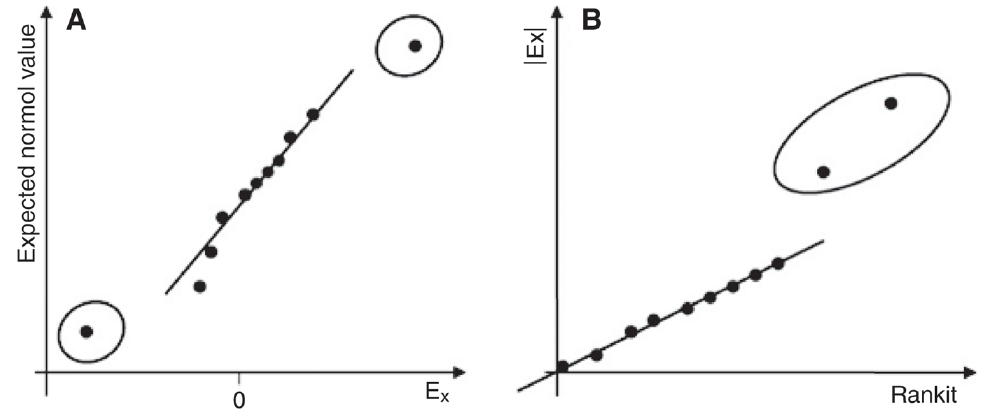
Figure 8: (A) Normal and (B) half-normal probability plots for an N = 12, f = 11 experimental design. A straight line is drawn through the non-significant effects. The significant effects are encircled; adapted from (Dejaegher and Vander Heyden 2007).